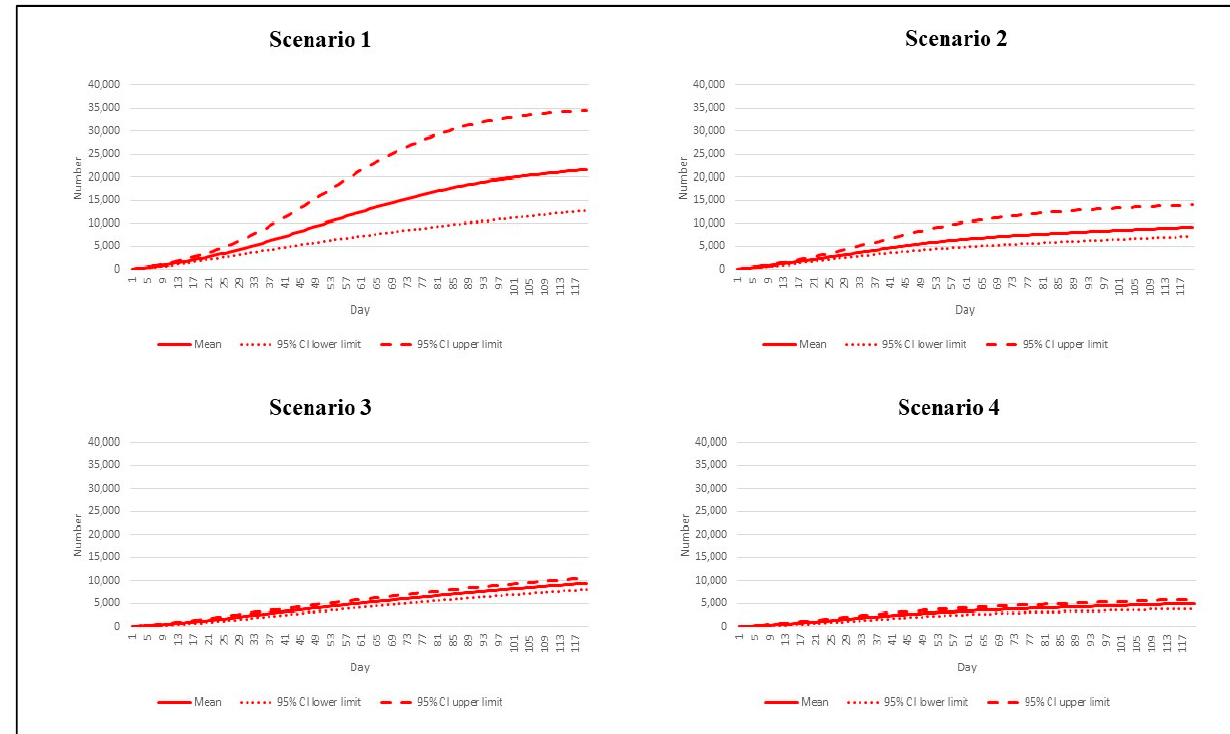
Figure 6. Cumulative death tolls by different epidemic scenarios.